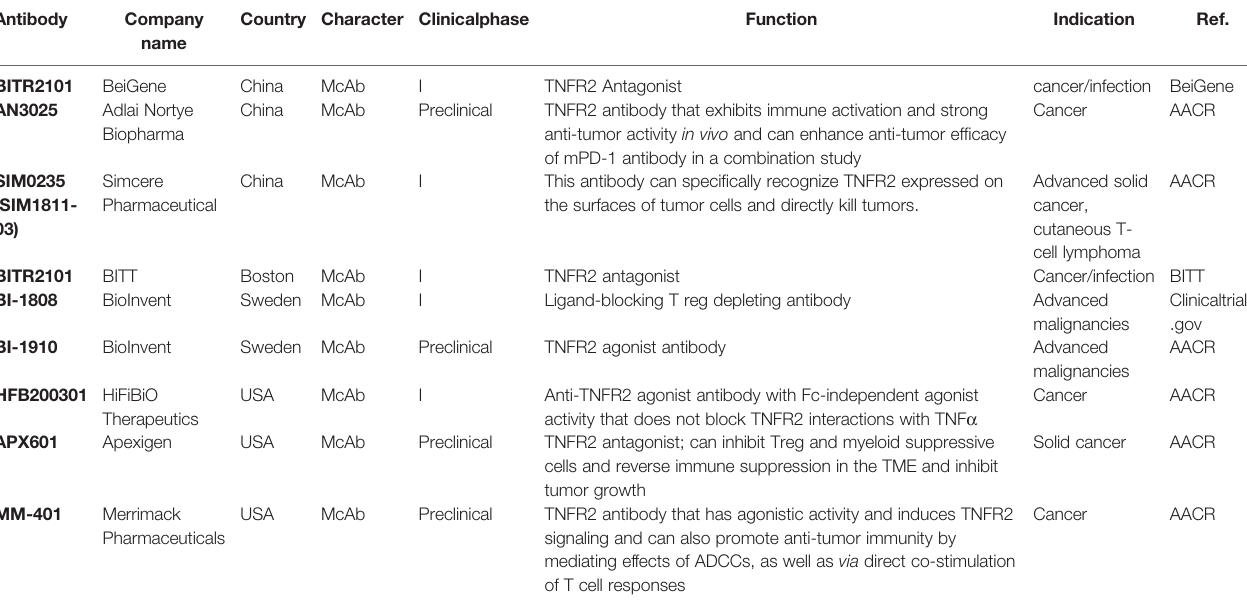
TABLE 2 | The clinical progress of TNFR2-Targeting Treatment antibody research and